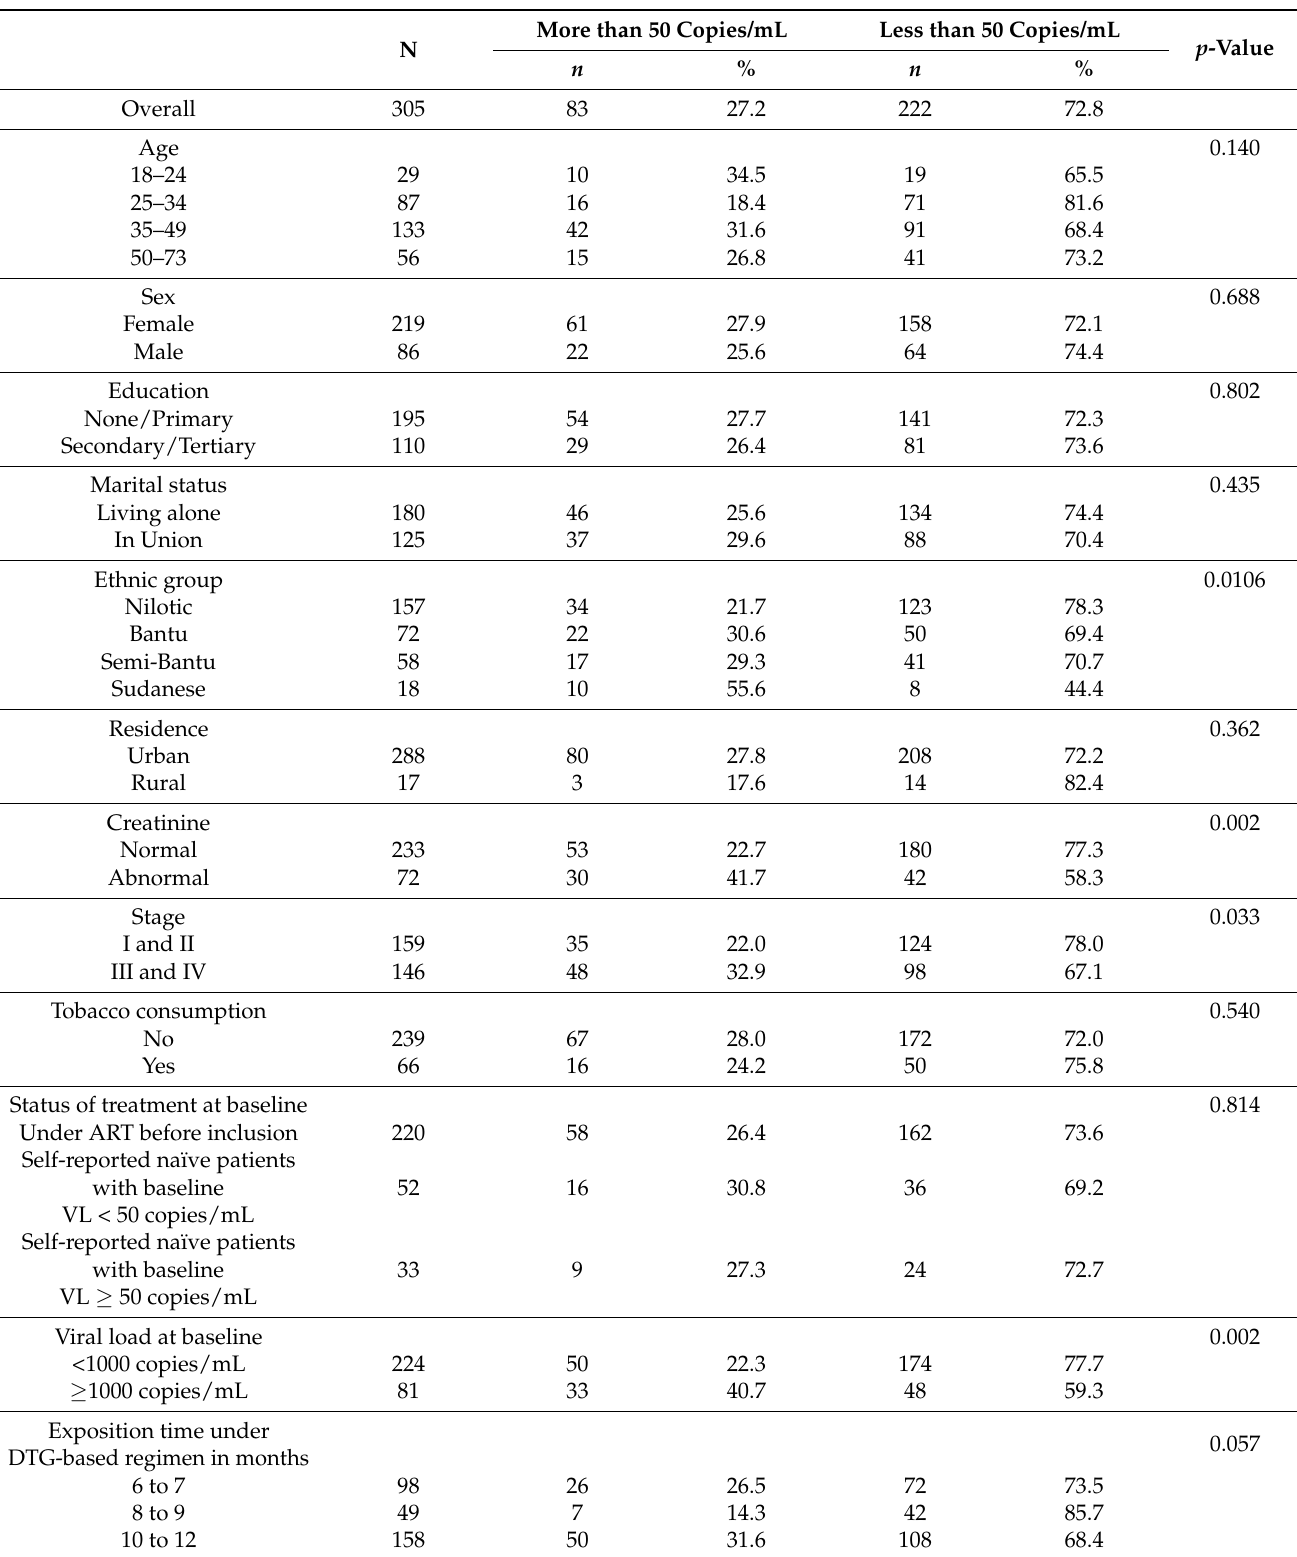
Table 2. Background characteristics of patients living with HIV under dolutegravir with and without virological suppression. More than 50 Copies/mL Less than 50 N